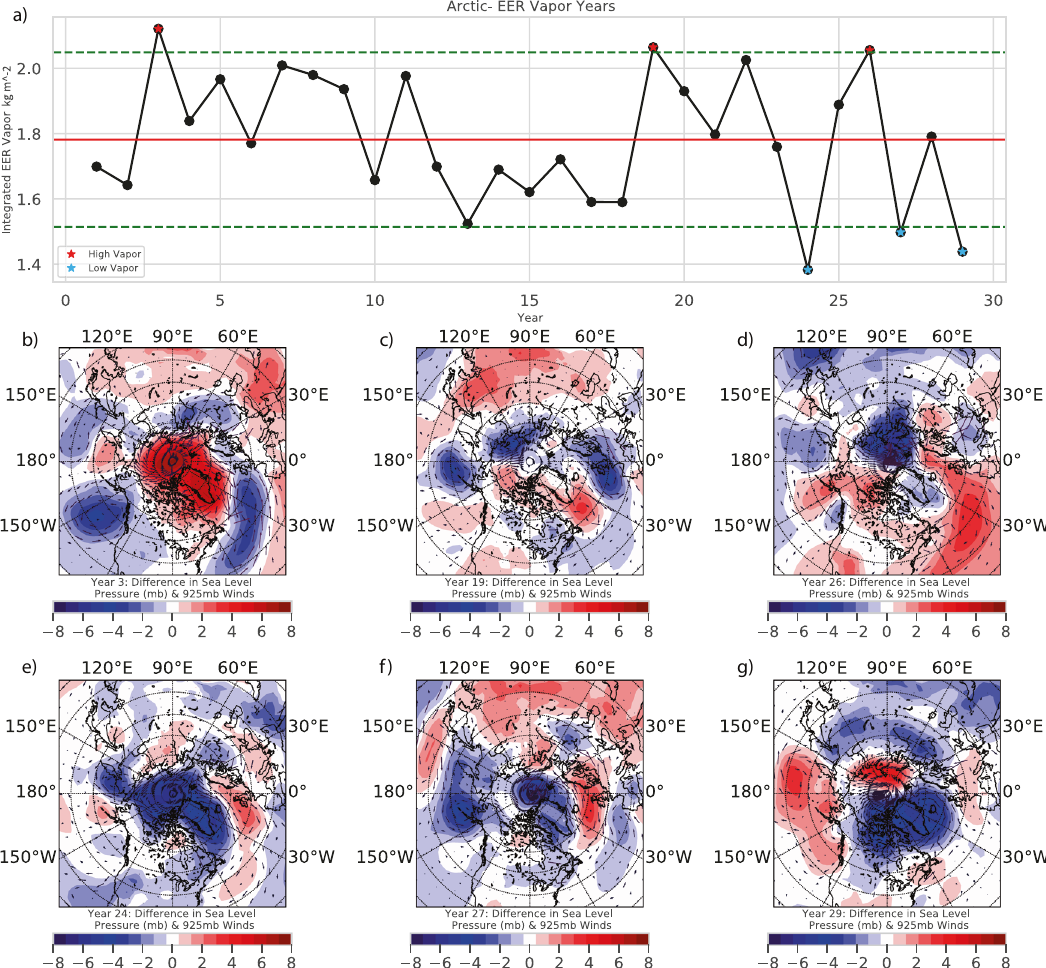
Fig. 8 SLP conditions associated with anomalous poleward EER vapor transport. a Mean summer EER vapor in the Arctic for each year of the simulation. The red stars denote anomalously high vapor years used in panels b and d , and the blue stars denote anomalously low vapor years used in panels e – g . b Year 3 SLP and 925 mb wind anomaly, c Year 19 SLP and 925 mb wind anomaly, d Year 26 SLP and 925 mb wind anomaly, e Year 24 SLP and 925 mb wind anomaly, f Year 27 SLP and 925 mb wind anomaly, and g Year 29 SLP and 925 mb wind